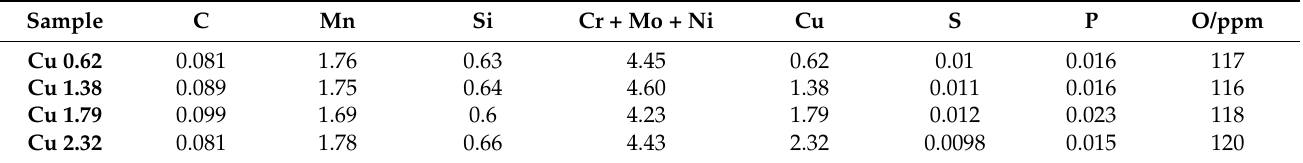
Figure 1. Macroscopic structure of deposited metal. Table 1. Chemical composition of deposited metals (wt%).